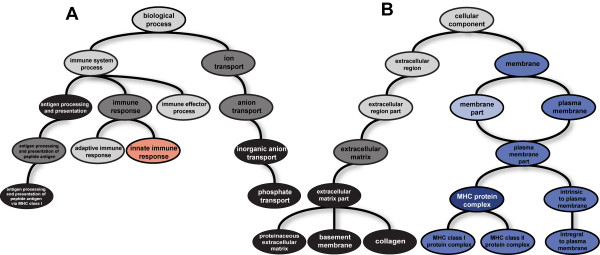
GO graphs of terms of the biological process (A) and cellular component (B) ontologies enriched among the positively selected HIV-interacting genes. Brightness of the nodes indicates the number of enrichment tests in which a term was found to be overrepresented (p < 0.05), ranging from three (light nodes) to five (darkest nodes) significant results out of six enrichments tests. The red node represents the innate immune response term, blue nodes represent membrane-related terms.